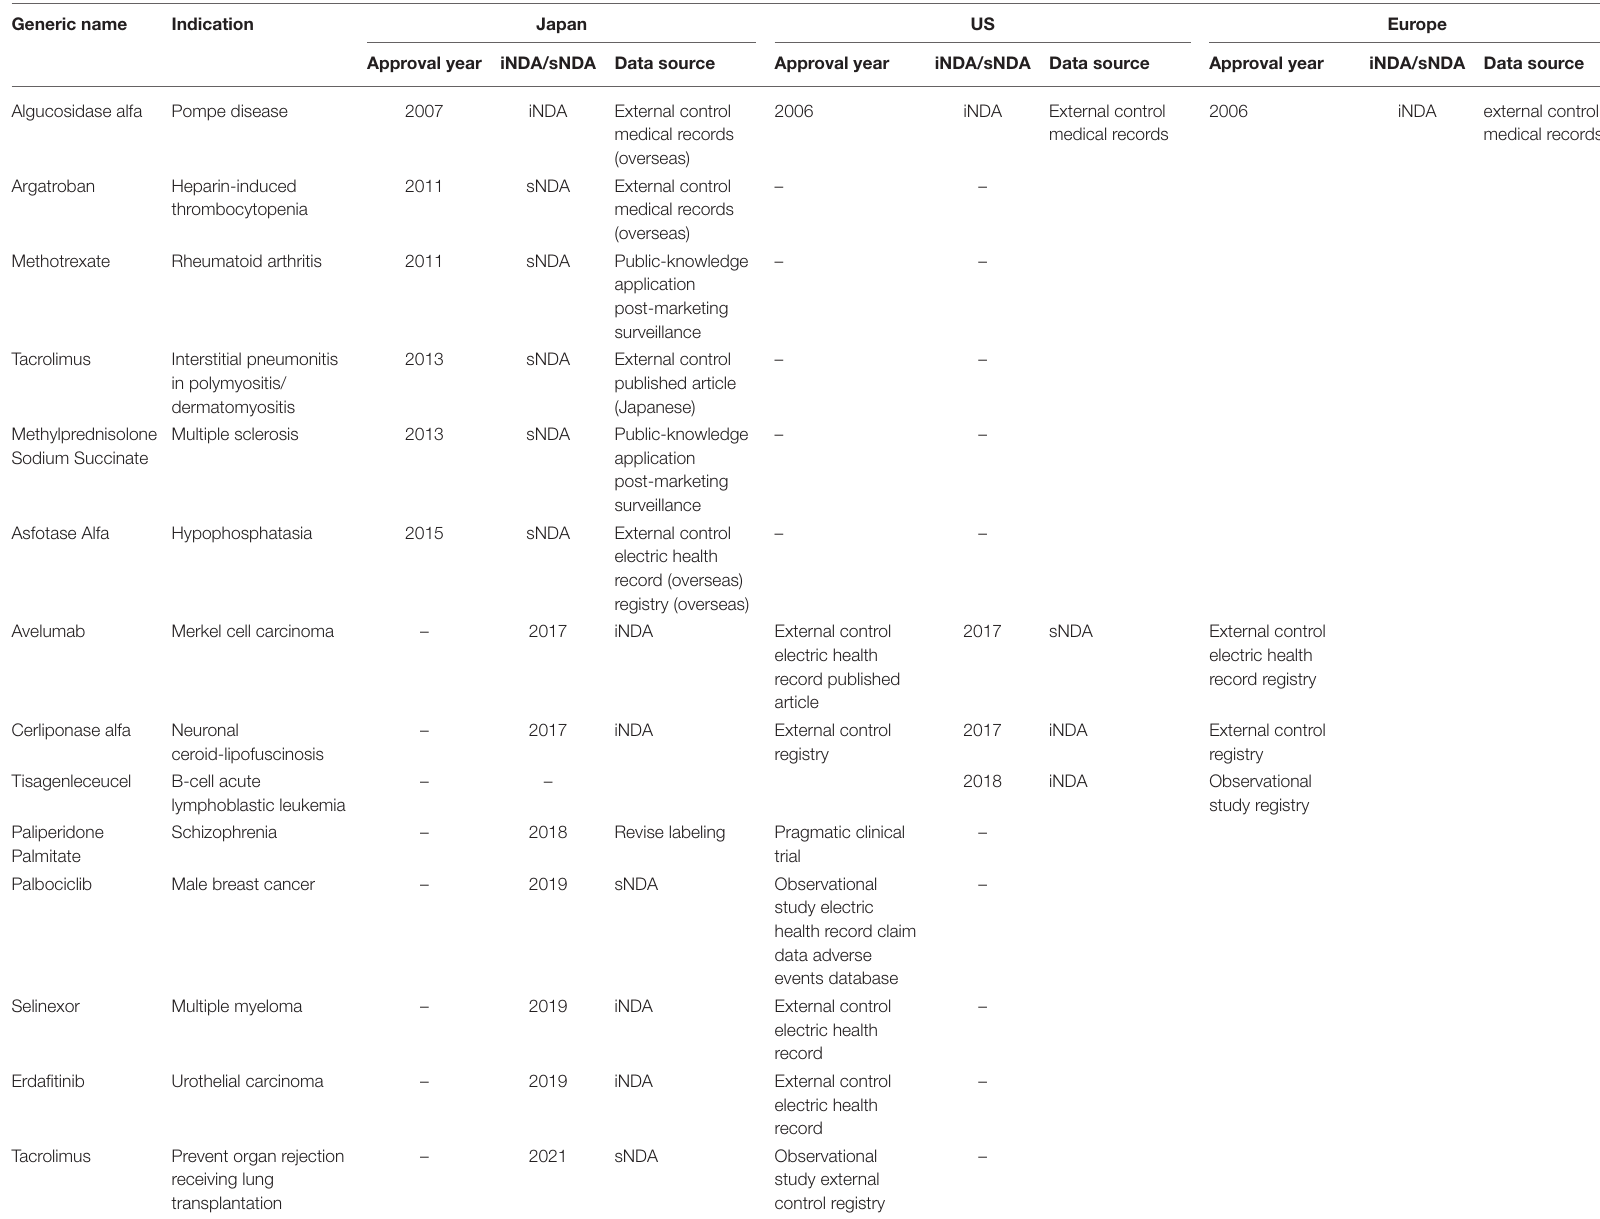
TABLE 1 | Approval applications using real world data in Japan, US and